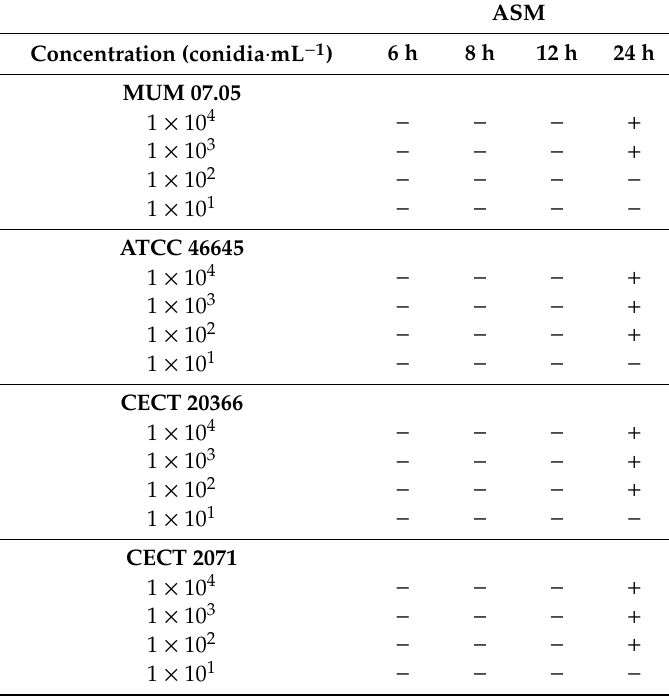
Table 2. Results of A. fumigatus detection in sheep blood and in artificial sputum medium (ASM) for the di ff erent times sampled. No positive results were obtained for concentrations lower than 1 × 10 2 conidias · mL − 1 . ( + )—positive fluorescent result by PNA-FISH; ( − )—negative fluorescent result by PNA-FISH.